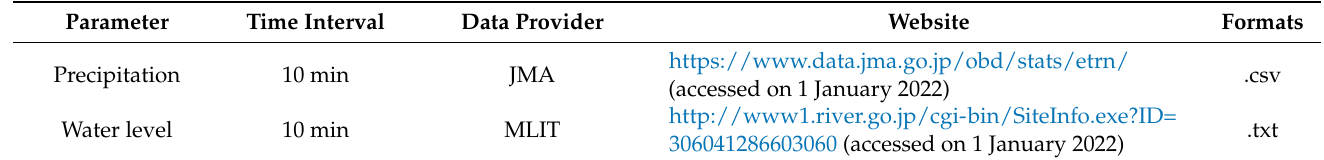
Figure 1. Lake Biwa and its catchment area including the main inflowing rivers and the major out- flow (Seta River) as well as the location of water level and discharge gauges and meteorological stations. Data from the Lake Biwa Work Office and the Automated Meteorological Data Acquisition System are shown in Table 1. This map was created using a Digital Elevation Model (Geospatial Information Authority of Japan). Table 1. Weather, water level, and water quality data. Abbreviations: JMA; Japan Meteorological Agency, MLIT; Ministry of Land, Infrastructure, Transport and Tourism.